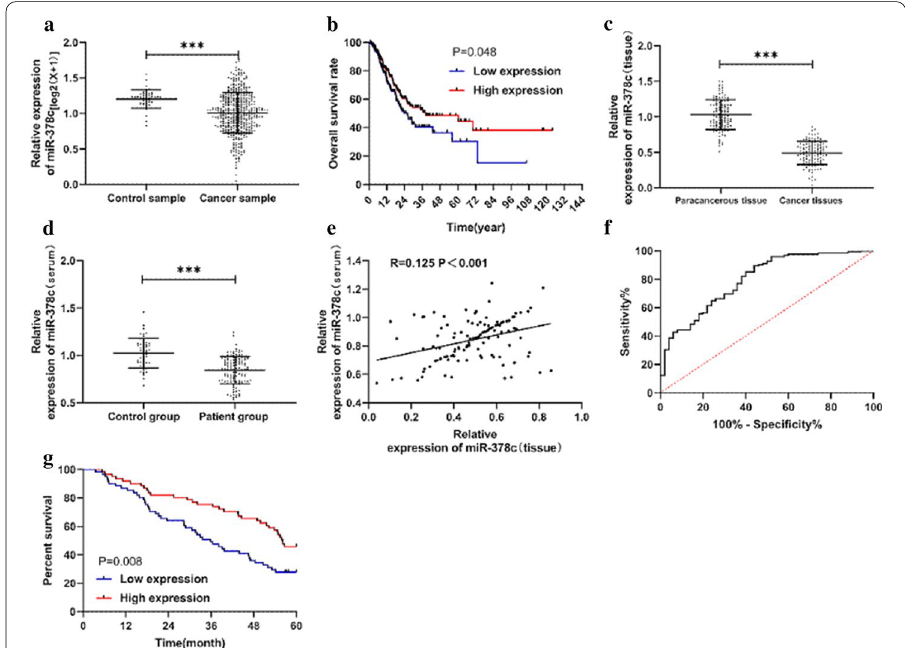
Fig. 1 Expression and clinical value of miR-378c in gastric cancer. a Relative expression of miR-378c in gastric cancer in TCGA database. b Relationship between miR-378c in TCGA database and the total survival of patients with gastric cancer. c Expression of miR-378c in the tissues of patients with gastric cancer. d Expression of miR-378c in serum of patients with gastric cancer. e Correlation analysis of miR-378c in serum and tumour tissue of patients with gastric cancer. f ROC curve of miR-378c expression in serum in the diagnosis of gastric cancer. g Relationship between miR-378c and survival of clinical patients. *** P < 0.001. R r =